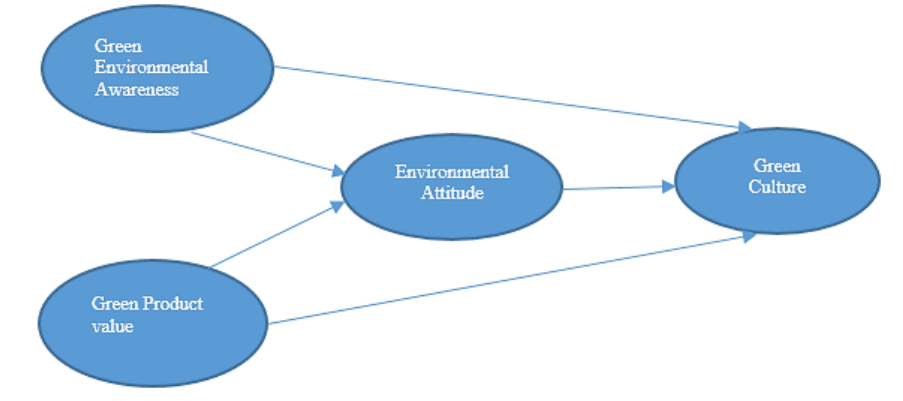
Fig. 1. Proposed research framework of this